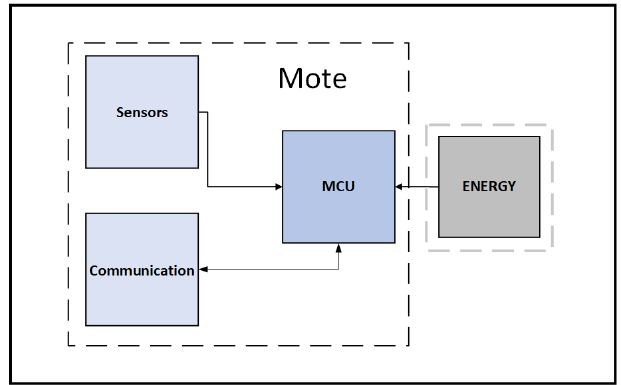
Figure 1. High level schematic of a mote including sensors, MCU and communication modules. The connection with the energy part is also depicted.